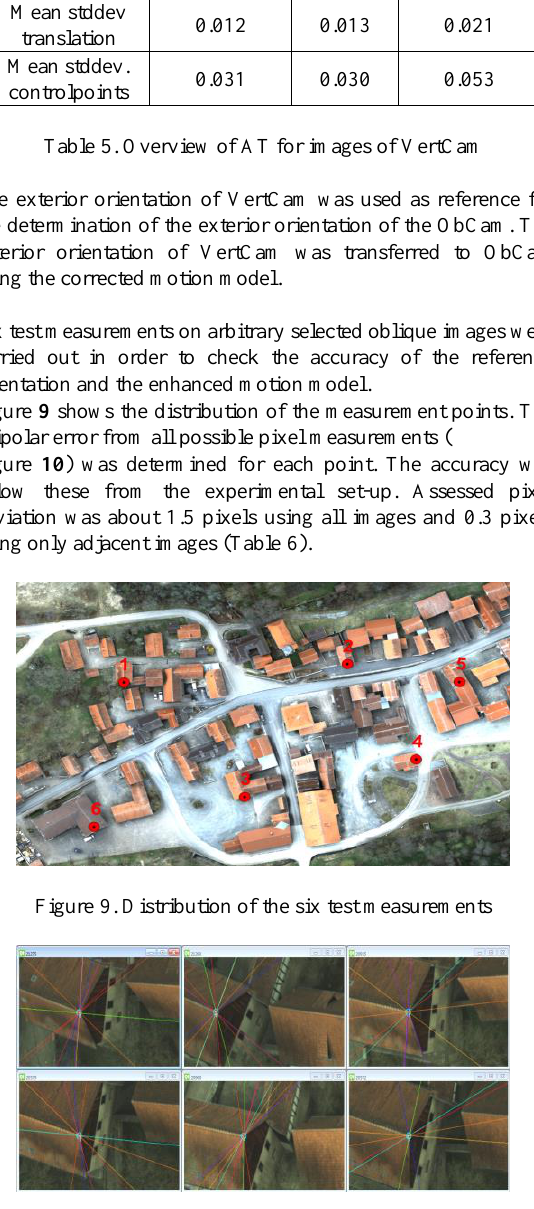
Figure 10. Epipolar geometry for one selected point in different oblique